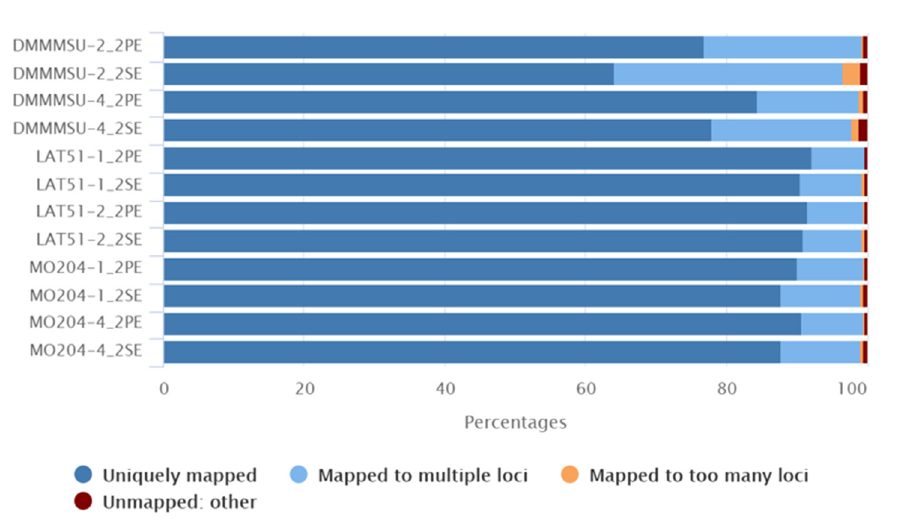
Figure 3. Overall alignment rate of RNA-seq reads to the transcriptome assemblies. Transcriptome assemblies are also evaluated based on the number and length of uni- genes (unique sequences reconstructed in the assembly; includes not only genes but all assembled contigs). According to the contig statistics in Table 4, the Trinity assembly had the lowest N50 (1313) and lowest median contig length (468). Cufflinks had the highest contiguity with the highest N50 (3414), highest median contig length (1738), and average